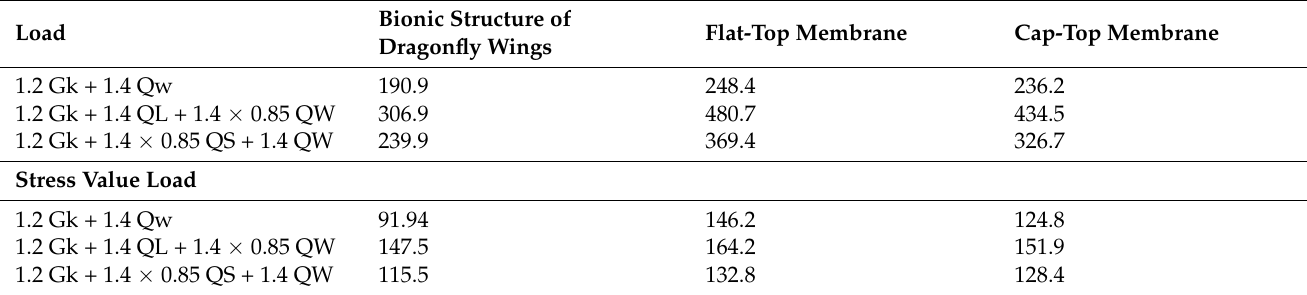
Table 8. Maximum displacement and stress values for the three types of carports